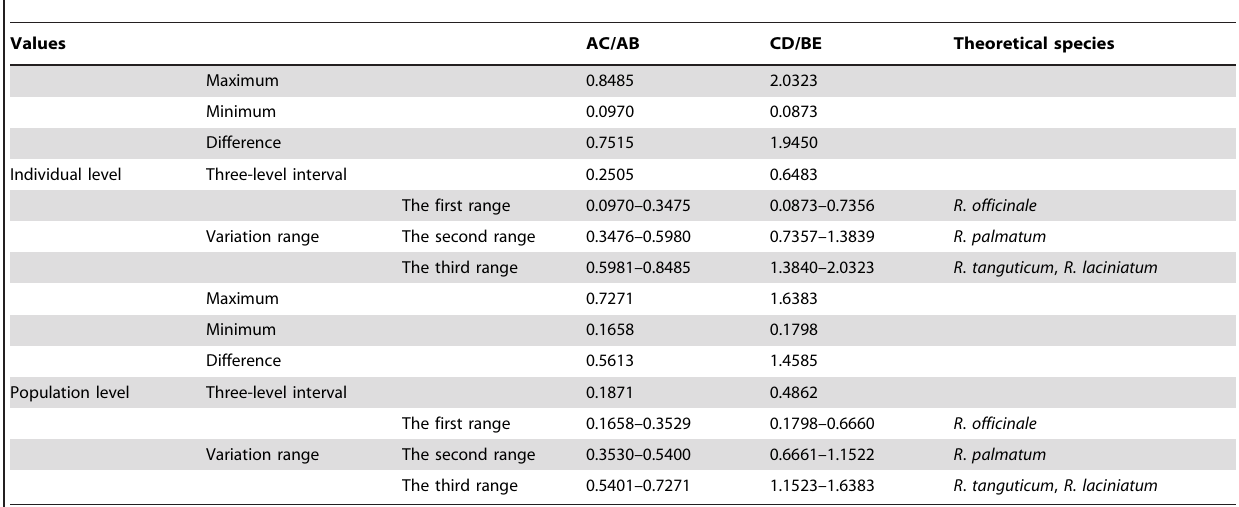
Table 4. The variation ranges of AC/AB and